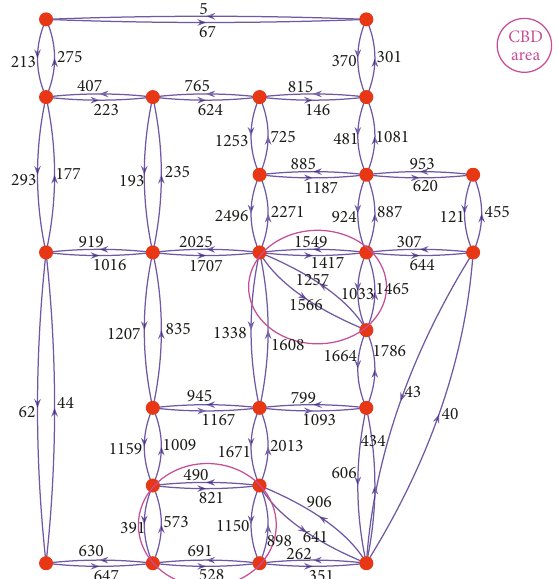
Figure 14: Equilibrium ride-sourcing trip flow on each link.